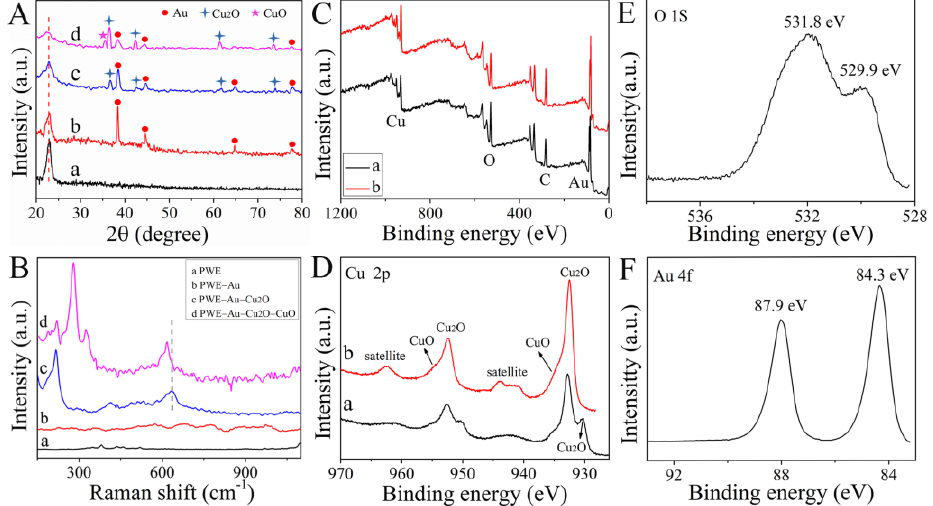
Figure 3. ( A ) XRD patterns and ( B ) Raman spectra (a) cellulose paper, (b) PWE, (c) PWE/Cu 2 O, and (d) PWE/Cu 2 O/CuO. ( C ) XPS survey scan of (a) PWE/Cu 2 O and (b) PWE/Cu 2 O/CuO. (D ) High − resolution XPS spectra of Cu 2p of (a) PWE/Cu 2 O and (b) PWE/Cu 2 O/CuO. High − resolution XPS spectra of ( E) O 1S and ( F ) Au 4f of PWE/Cu 2 O/CuO.